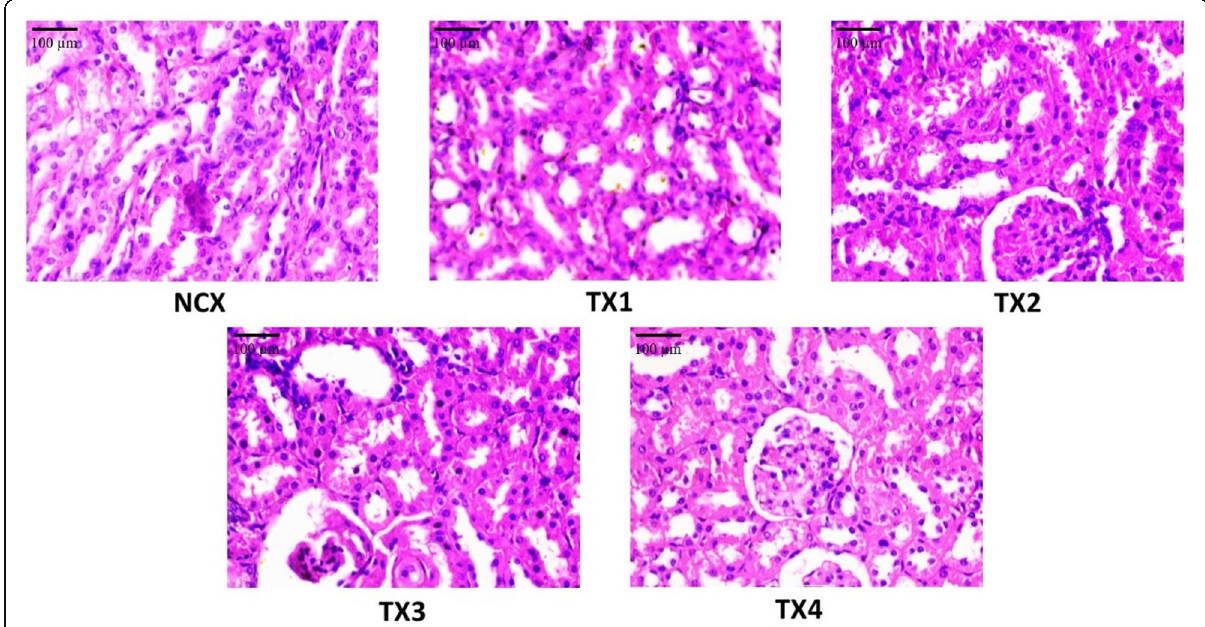
Fig. 2 The histopathology of kidney from the different group of swiss albino mice (40 × magnification; Scalar bar: 2100 μ m).). No significant damage was observed in the kidney architecture of any treated groups rats. The microscopic analysis of the kidney in all treatment groups displayed normal architecture of the medullary and cortical structures, including glomeruli and renal tubules. No histological irregularities were detected in the kidney when compared to normal control group (NCX). Where NCX: Normal control group; TX1: Sub-acute toxicity group 1 (250 mg/kg/day/p.o); TX2: Sub-acute toxicity group 2 (500 mg/kg/day/p.o); TX3: Sub-acute toxicity group 3 (1000 mg/kg/day/p.o); TX4: Sub-acute toxicity group 4 (2000